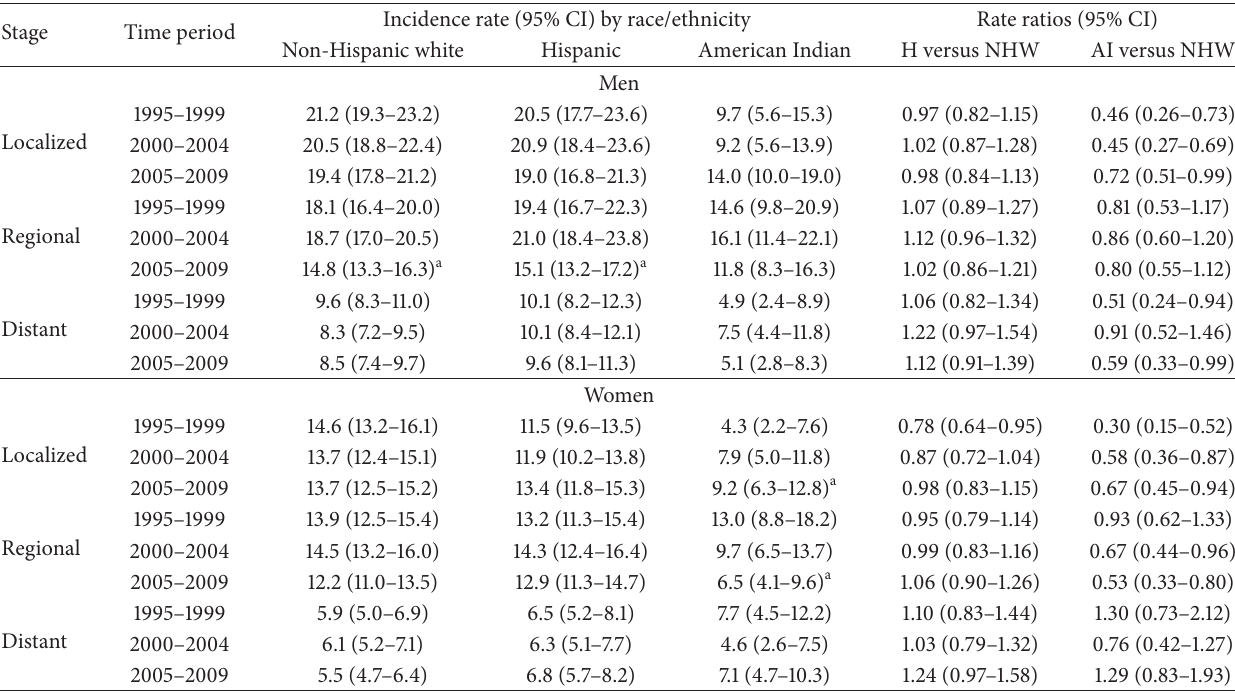
Table 2: Average age-adjusted colorectal cancer incidence rates by stage, time period, gender, and race/ethnicity; New Mexico, 1995–2009. Stage